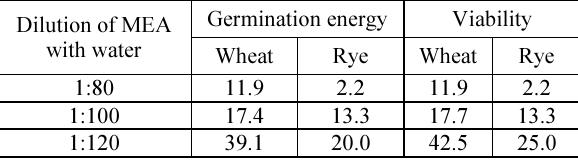
Table 2. Effect of MEA waste on viability of seeds (%) Germination energy Dilution of MEA with water